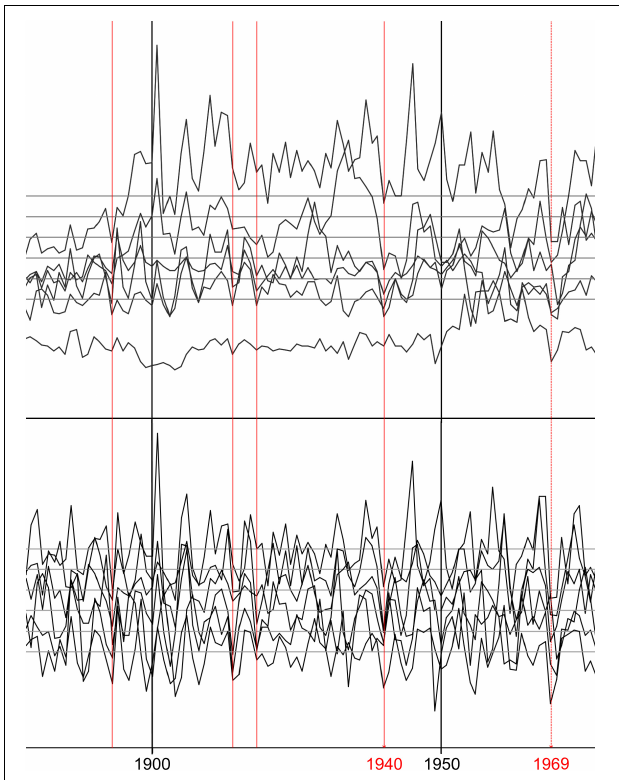
FIGURE 5 | The central section of the graph of TRW series for six pines of group 3 along coastline stretch 5 in synchronous arrangement: before data indexation (top) and after indexation (bottom). The most pronounced pointer year is 1940, when the winter was very harsh. The narrowing of ring widths in 1969–1970 corresponds very well to the time of two very strong autumn storms (1967 and 1969), in the course of which part of the coastal bluff was washed away.